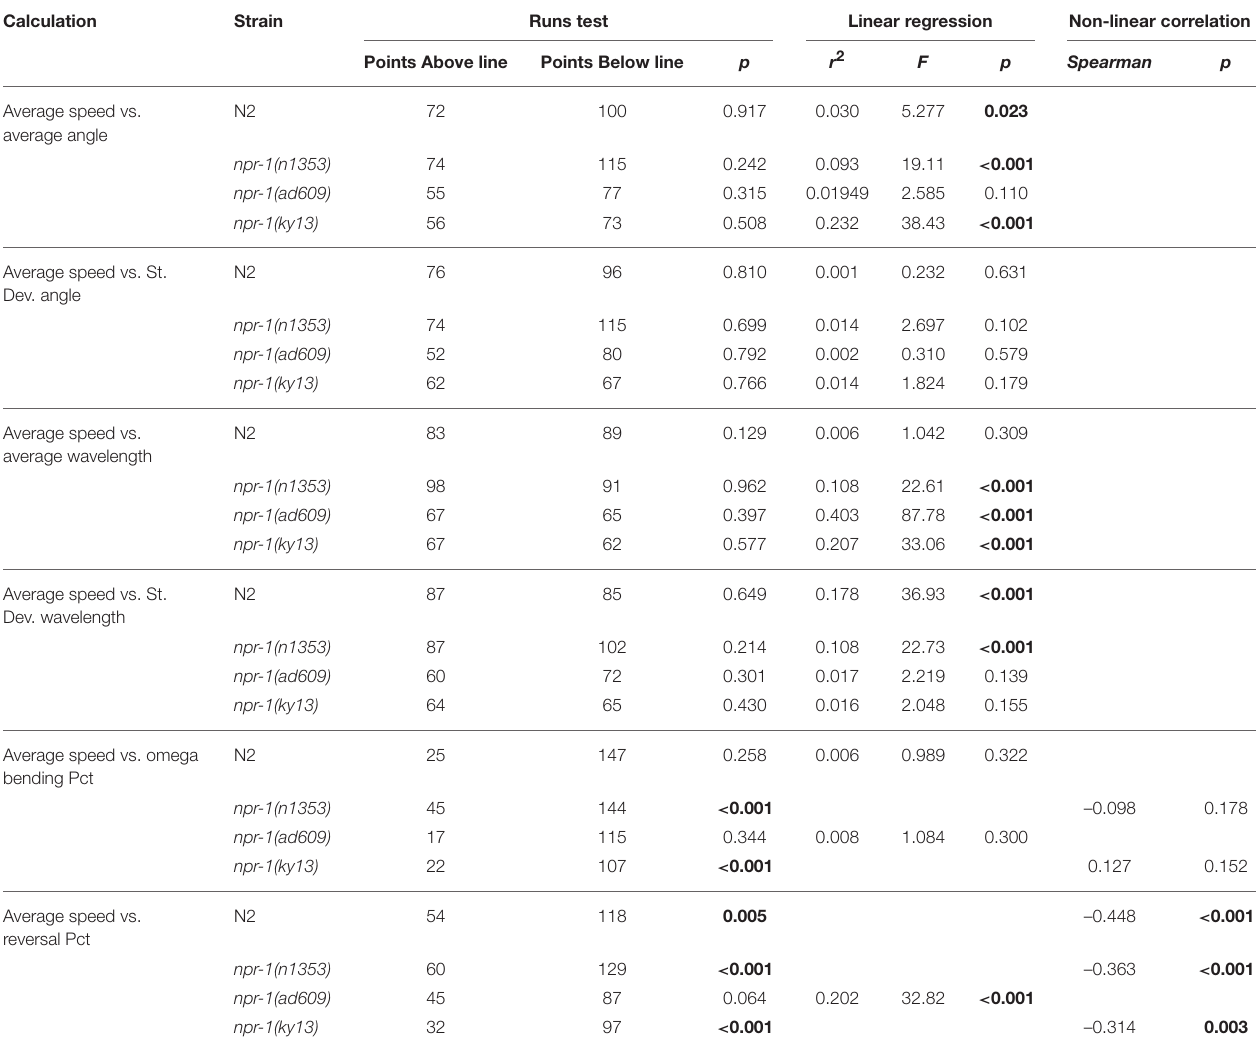
Average speed vs. reversal